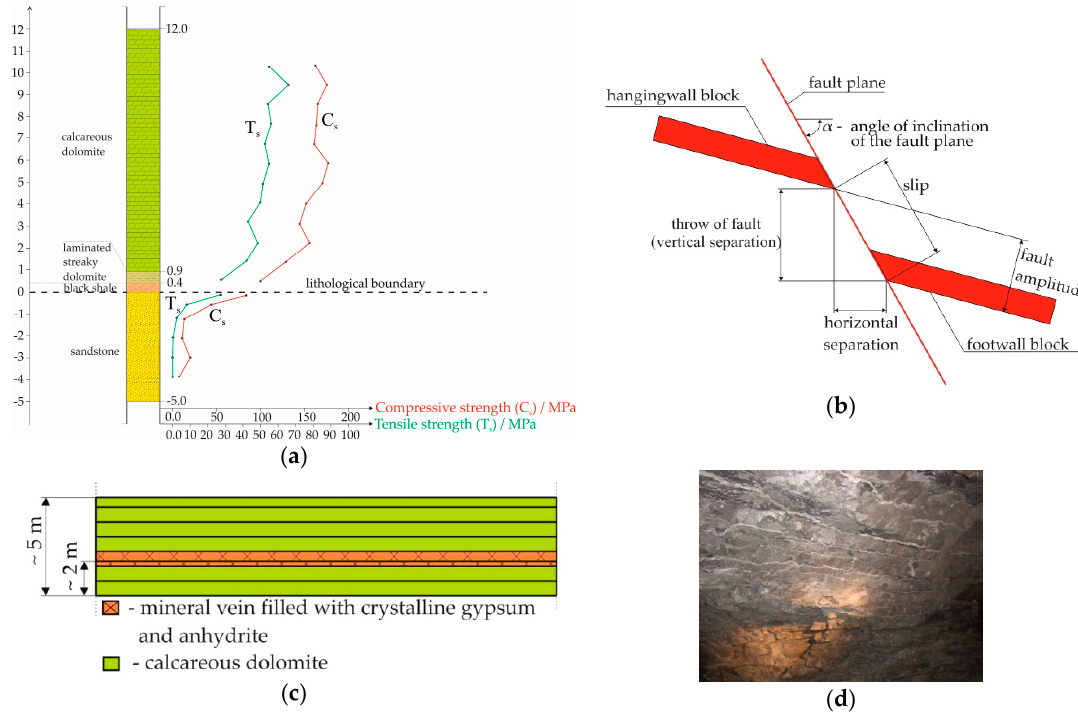
Figure 2. Geological factors affecting on the stability of a room excavation: (a) Variability of rock compressive and tensile strength; (b) Fault parameters; (c) Stratification of roof layers; (d) Stratification roof with visible horizontal white layers of gypsum and anhydrite.